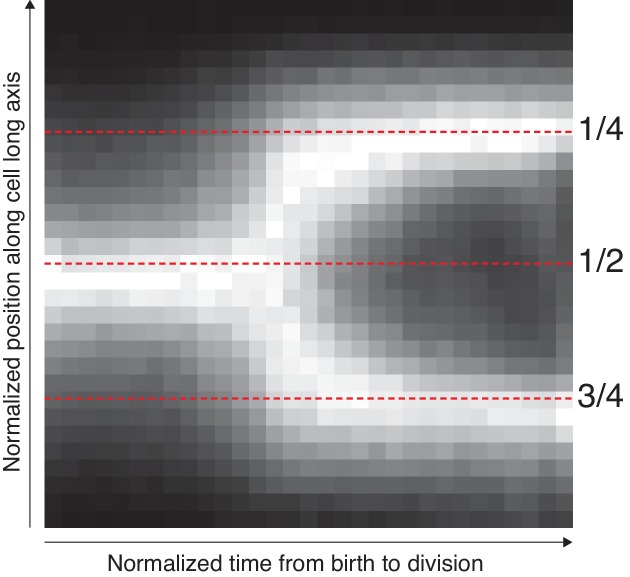
Average localization of the origin in cells growing in M9 glycerol.The position along the cell axis and the cell-cycle time of all detected spots were collected. The longitudinal position was scaled with cell length to indicate the relative position in the cell. The cell cycle time was normalized between 0 and 1. The figure shows these space-time data as a 2D histogram, where additionally each time point (column) has been normalized to have a maximum bin value of 1. The mid-cell and quarter-cell (mid-cell of daughter cell) positions are indicated with dotted lines.